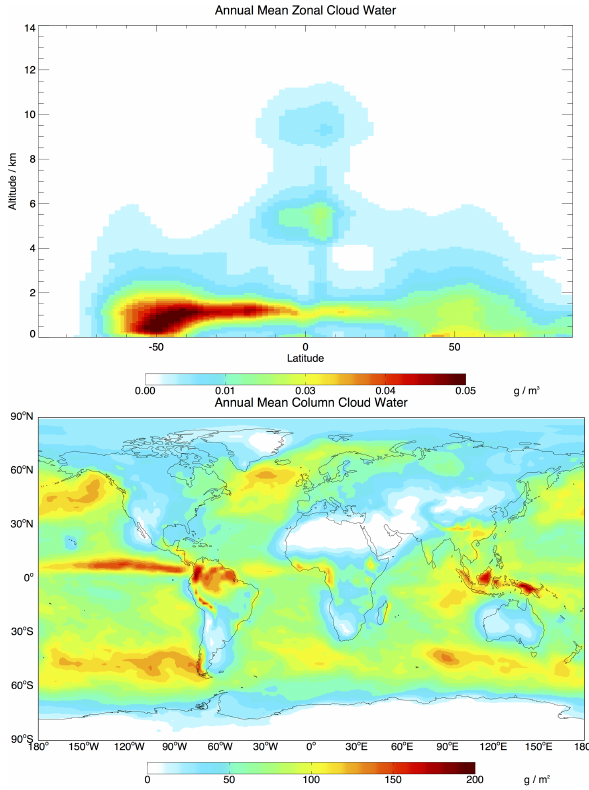
Figure 12. Annually averaged cloud water in the GEOS5 fields as (top) a column total and (bottom) a zonal